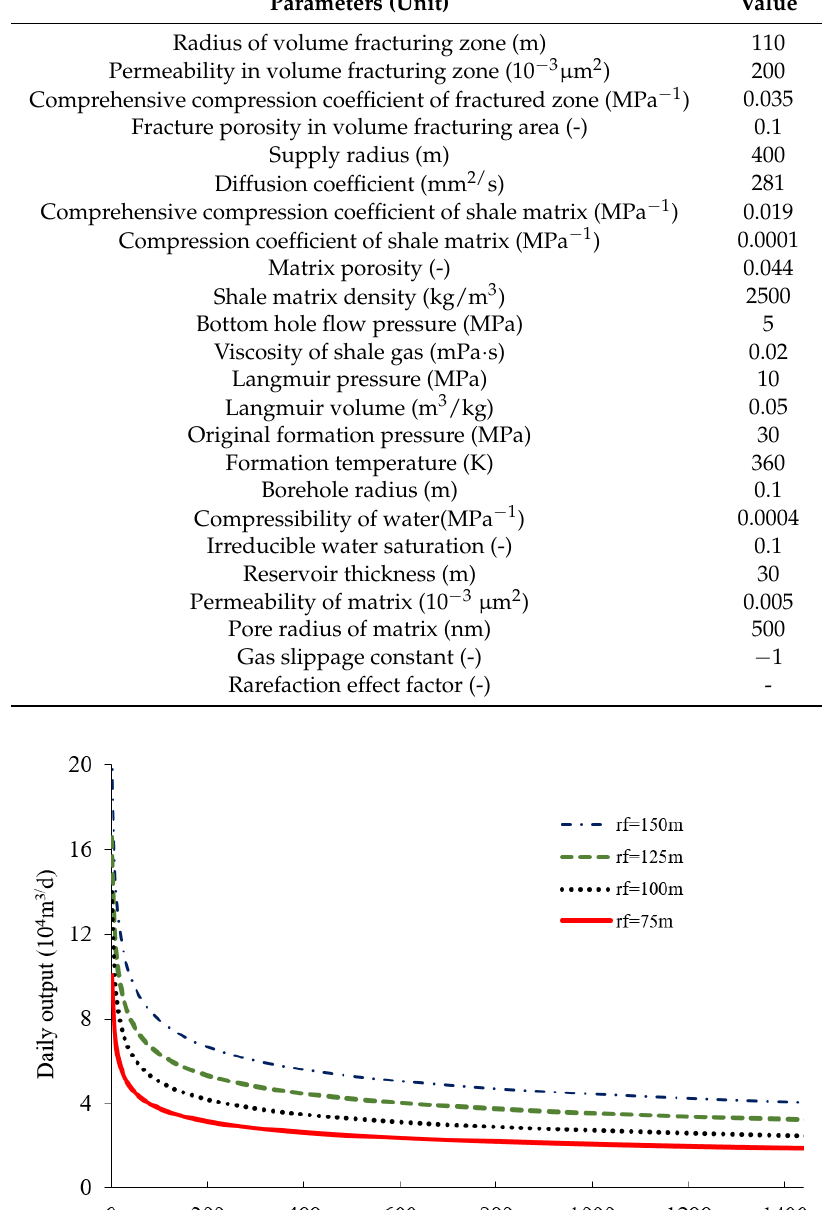
Table 1. Model calculation basic parameters table.